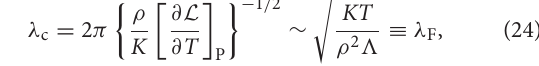
Frontiers in Astronomy and Space Sciences |